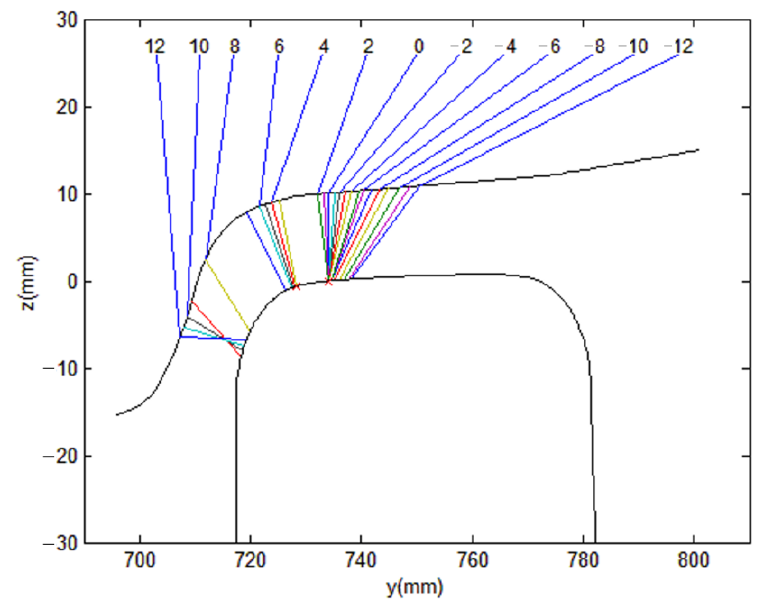
Figure 11. Position of contact points on wheel and rail depending on lateral displacement of wheelset (wear and fatigue-optimized wheel profile).